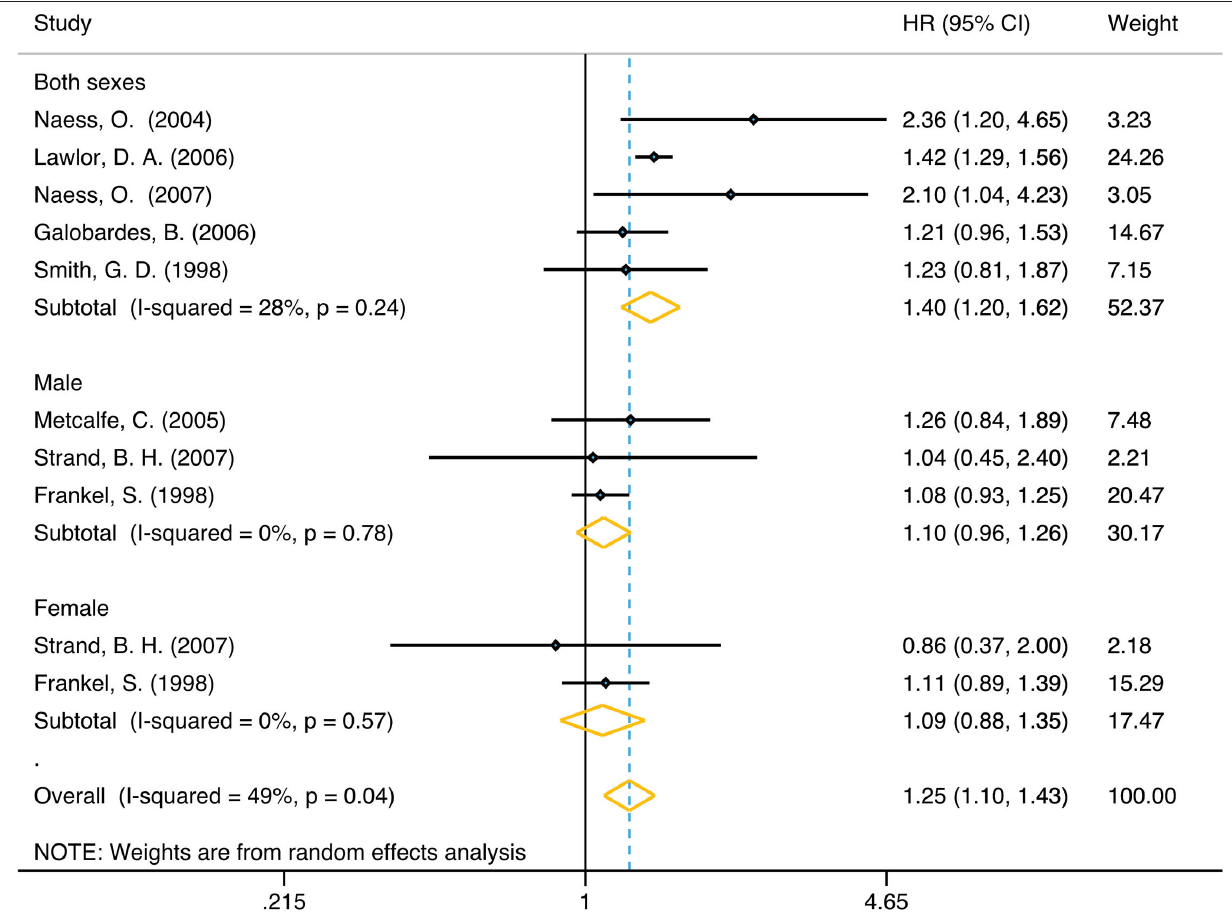
FIGURE 3 | Forest plot of population-based cohort studies of family SEP and lung cancer, stratified by sex (adjusted